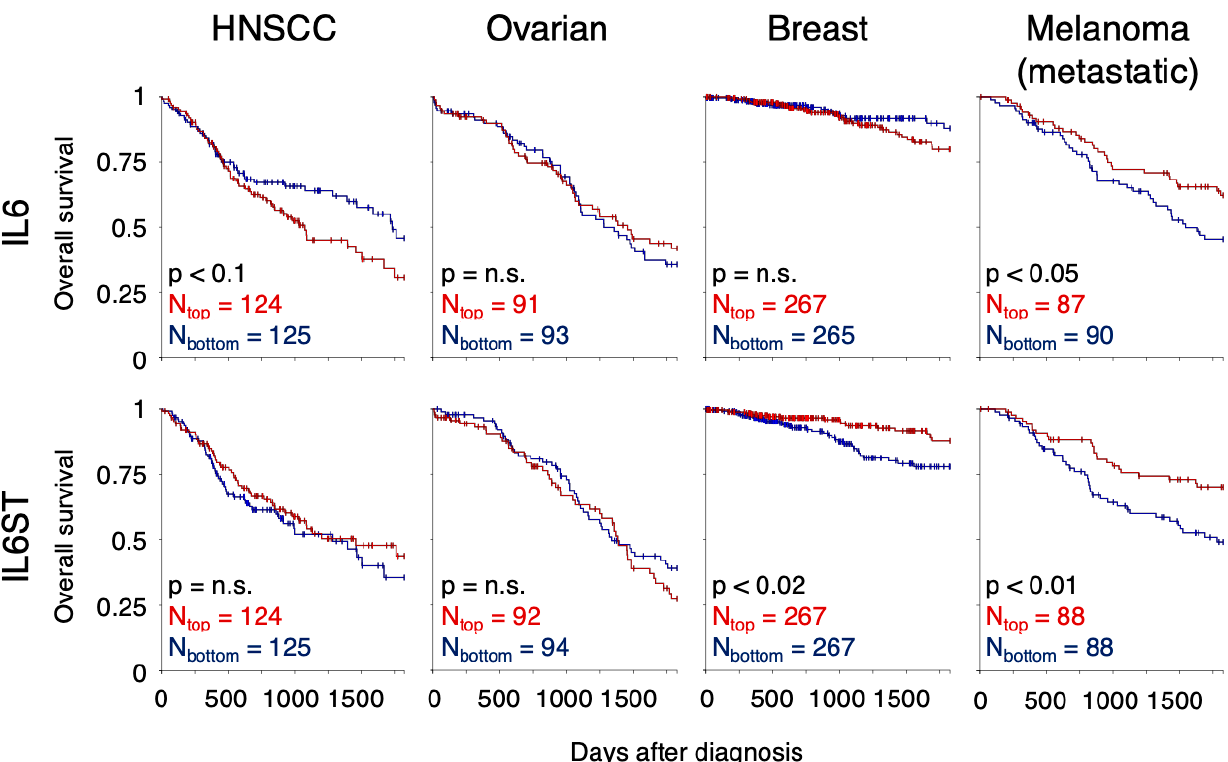
Figure 3. Correlation of patient survival with mRNA expression of IL-6 pathway components. Overall survival of patients suffering from HNSCC, ovarian cancer, breast cancer, or metastatic melanoma is evaluated for patients with different levels of IL6 mRNA expression ( top ) and IL6ST mRNA expression ( bottom ). Survival of the patients with the highest gene expression (4th quartile, N top patients) was compared with the survival of the patients with the lowest expression (1st quartile, N bottom ) using Kaplan–Meier curves and the log-rank test. The analysis was performed within the Xena platform